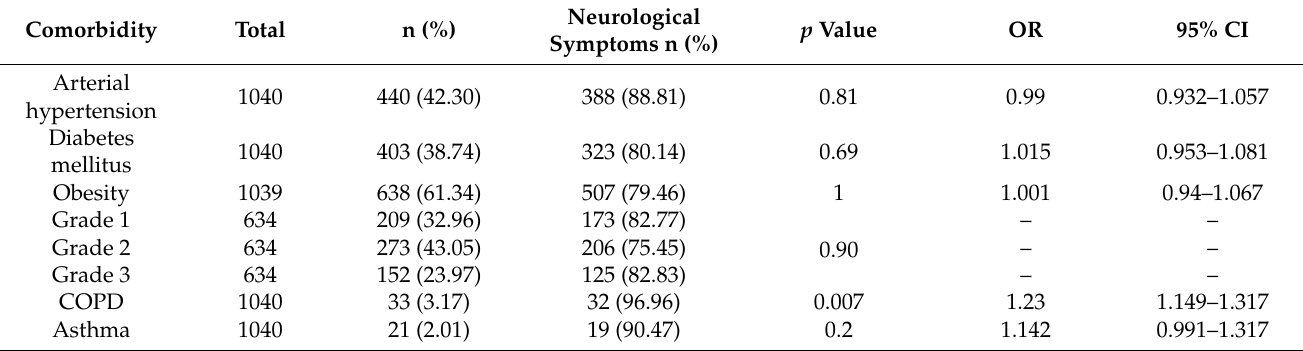
Table 1. History of disease and frequency of development of neurological symptoms.